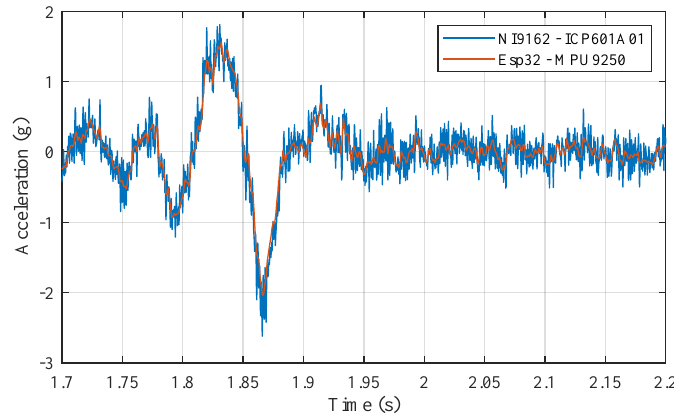
Figure 5. Comparative test for validation of accelerometer